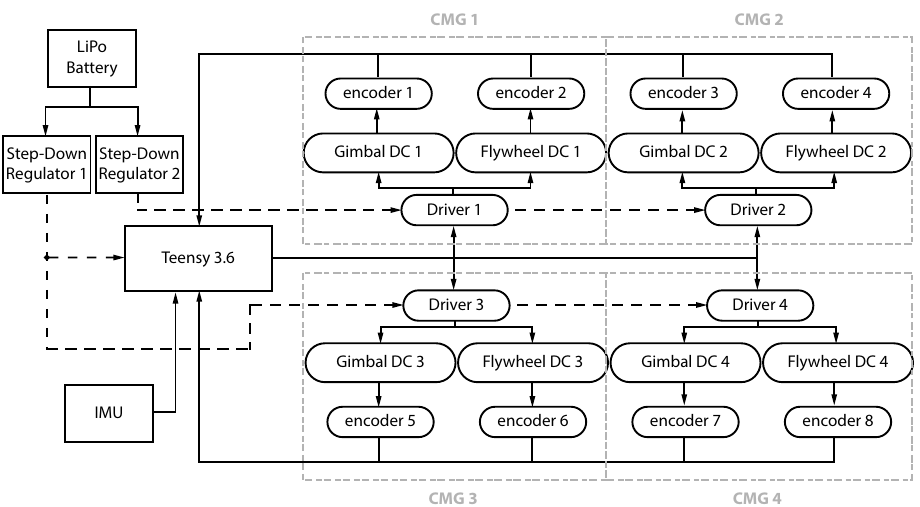
Figure 2. Avionics system/board block diagram with all